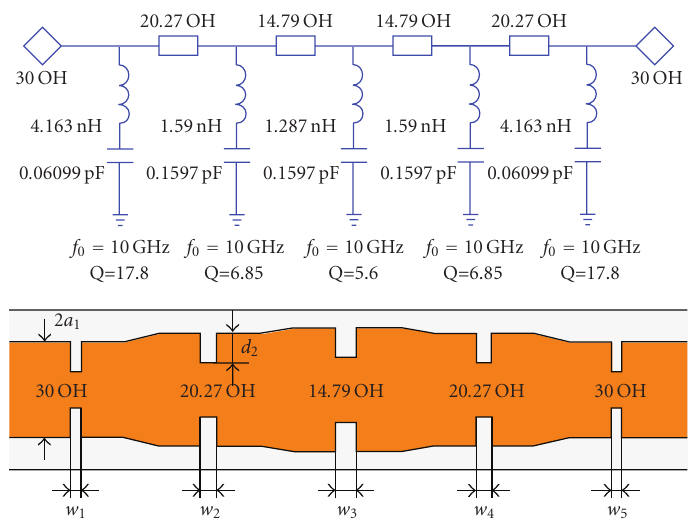
Figure 9: Low-pass block diagram and the general view of the Chebyshev filter prototype.